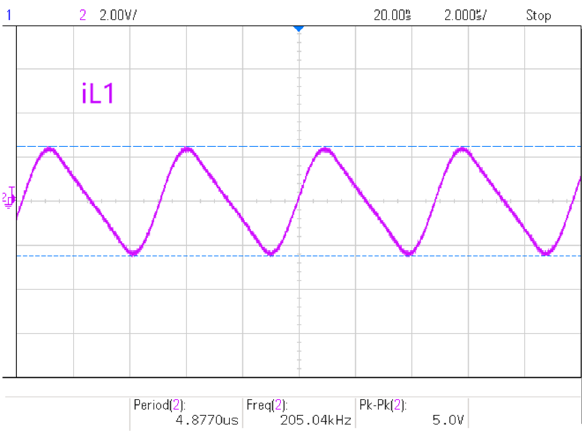
Figure 28. IDC inductive current waveform.